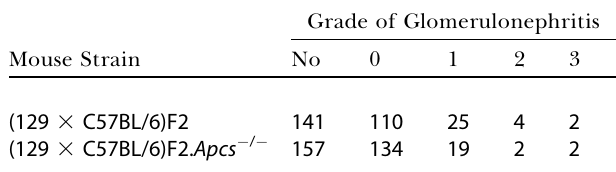
Table 2. Histological Assessment of Kidney Sections in Apcs (cid:1) / (cid:1) and Wild-Type (129 3 C57BL/6)F2 Female